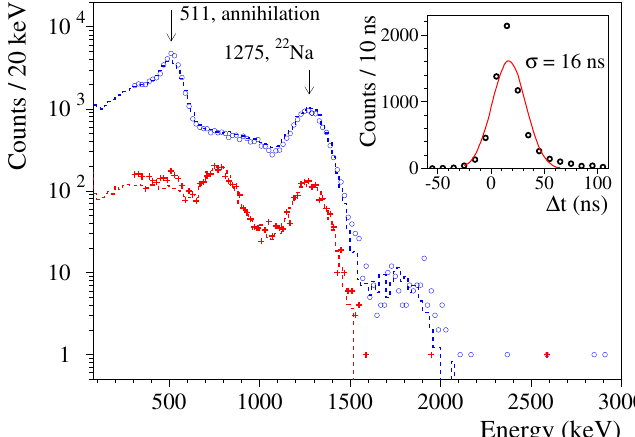
Figure 5. Energy spectra of 22 Na γ quanta measured by the 106 CdWO 4 detector: with no coincidence cuts (blue circles) and in coincidence with energy 511 keV in at least one of the CdWO 4 counters (red crosses). The data simulated by using the EGSnrc Monte Carlo code are drawn by dashed lines. (Inset) Distribution of the 106 CdWO 4 detector pulses start positions relative to the CdWO 4 signals with the energy 511